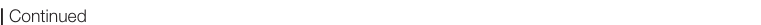
FIGURE 2 | Continued mEPSCs: (C,D); 8 month-old mIPSCs: (E,F) ; 12 month-old mIPSCs: (G,H) ]. Comparison between cumulative probability distributions was made using the Kolmogorov–Smirnov test ( ∗ P < 0.05; ∗∗ P < 0.01; ∗∗∗ P < 0.001); bar graphs represent mean ± standard error. n = 8 cells, 8 slices, from 5, 8 month-old Wild type water mice vs. n = 8 cells, 8 slices, from 5, 8 month-old Wild type caffeine-treated mice; n = 8 cells, 8 slices, from 5, 8 month-old Wild type water mice vs. n = 9 cells, 9 slices, from 5, 8 month-old Tau water mice; n = 9 cells, 9 slices, from 5, 8 month-old Tau water mice vs. n = 9 cells, 9 slices, from 5, 8 month-old Tau caffeine-treated mice; n = 8 cells, 8 slices, from 5, 8 month-old Wild type caffeine-treated mice vs. n = 9 cells, 9 slices, from 5, 8 month-old Tau caffeine-treated mice; n = 8 cells, 8 slices, from 5, 12 month-old Wild type water mice vs. n = 8 cells, 8 slices, from 5, 12 month-old Wild type caffeine-treated mice; n = 8 cells, 8 slices, from 5, 12 month-old Wild type water mice vs. n = 7 cells, 7 slices, from 4, 12 month-old Tau water mice; n = 7 cells, 7 slices, from 4, 12 month-old Tau water